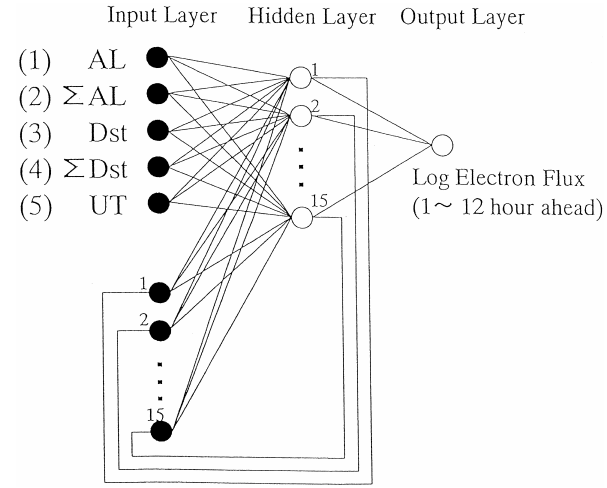
Fig. 3. Architecture of the optimized Elman neural network.